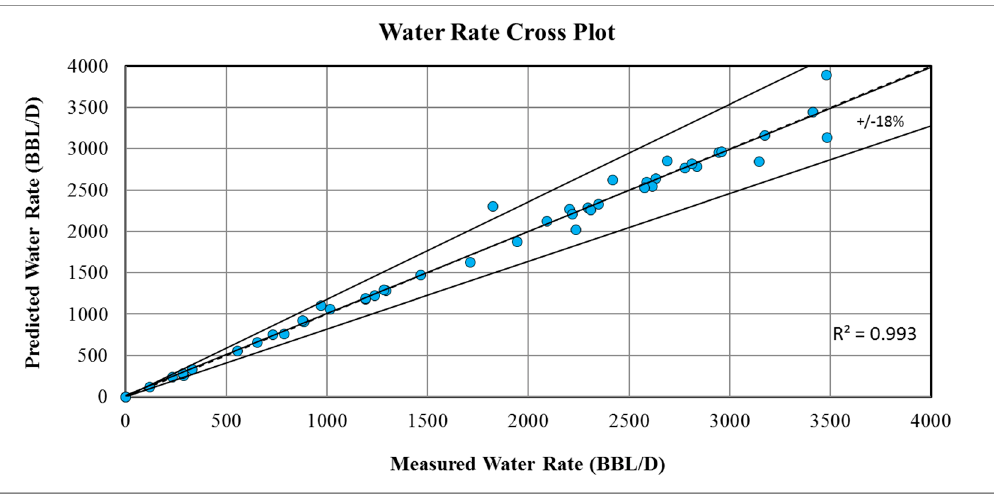
Figure 9. Predicted vs measured water rate using the Blasius correlation.